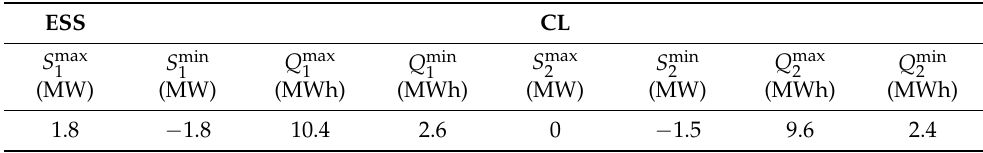
Table 3. Specifications of aggregated ESS and aggregated